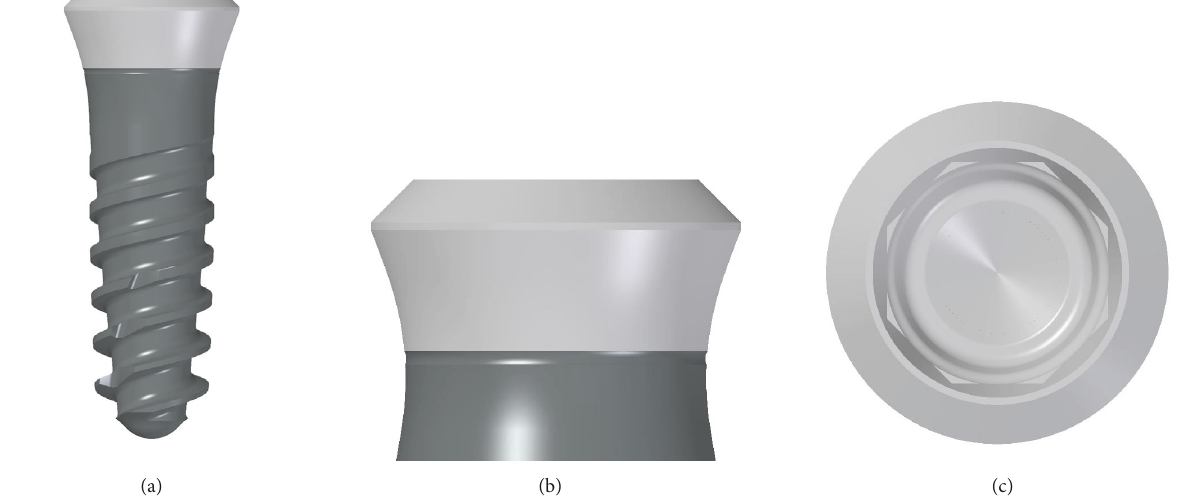
Figure 2: Drawing of the tapered, double lead threads implant used in this study. (a) Apical threads, deeper and cutting, favour insertion, and initial stability, whereas squared coronal thread enhances bone condensation. (b) Back-tapered collar provides excellent cortical bone management, improving soft tissue support. (c) Octagonal conical connection (2mm in depth with 8 ∘ cone) that guarantees an excellent seal, reducing the risk of micromovements between the implant and the abutment.